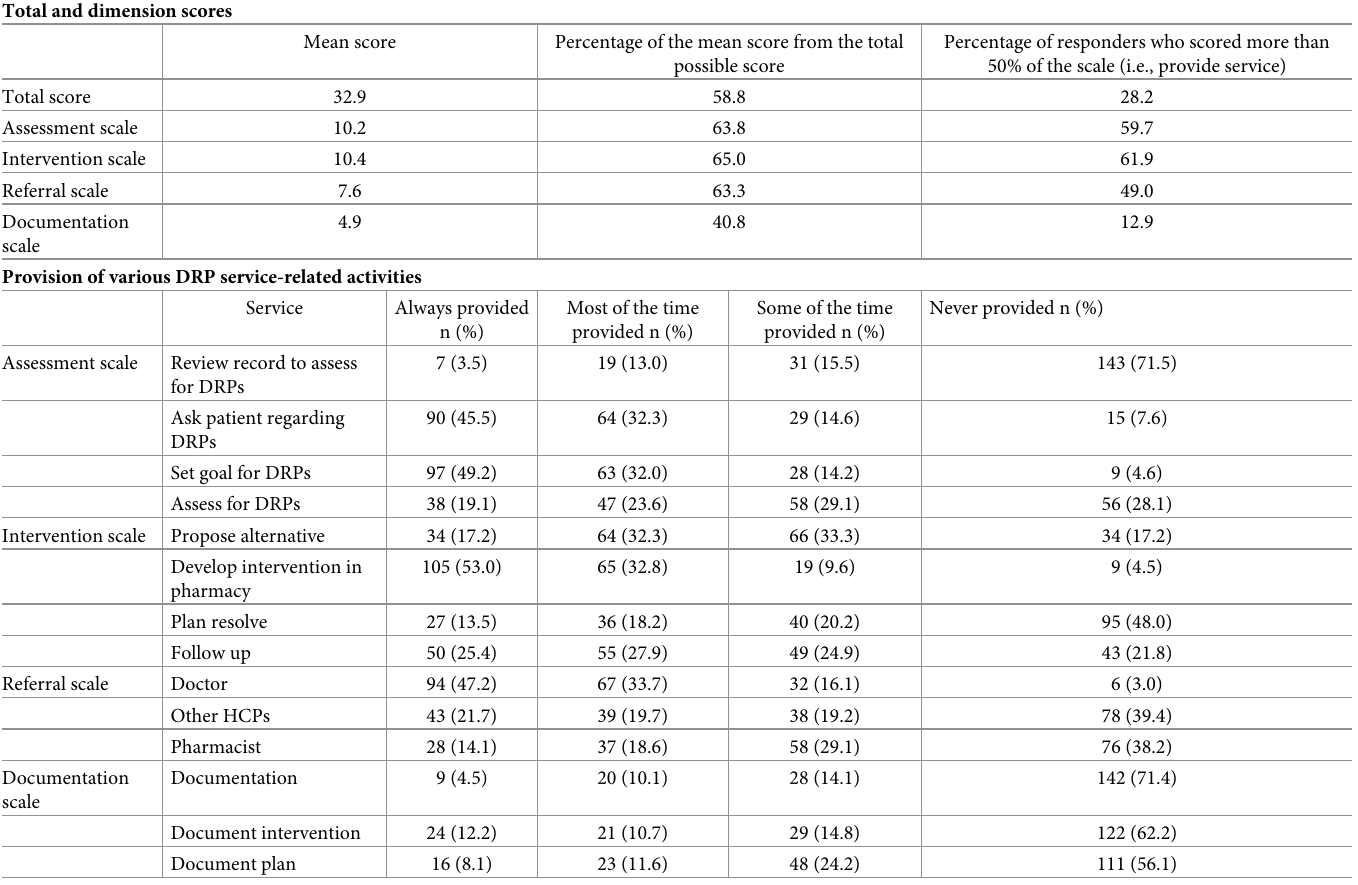
Table 3. Total and dimension scores and provision of various DRP service-related activities among community pharmacists (N = 200). Total and dimension scores Mean score Percentage of the mean score from the total Percentage of responders who scored more than possible score 50% of the scale (i.e., provide